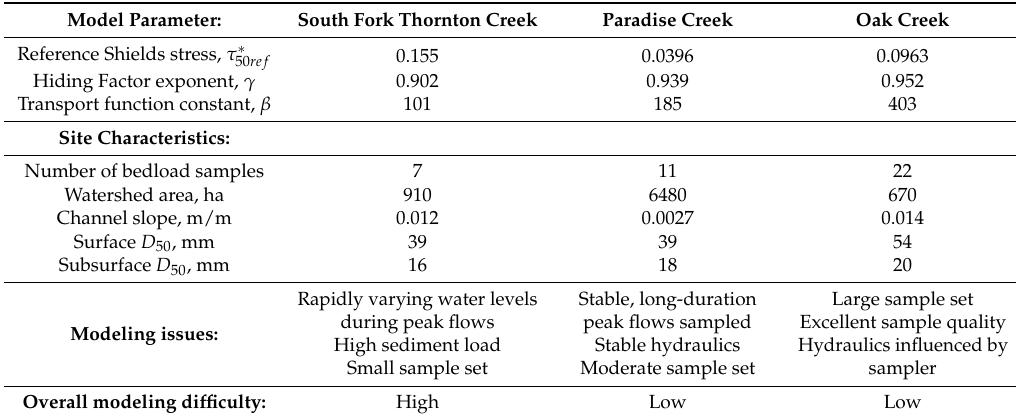
Table 1. Summary of site and watershed characteristics, and model calibration constants for the three examples described in the text. Salient modeling issues and calibration difficulty are also summarized. See the text for